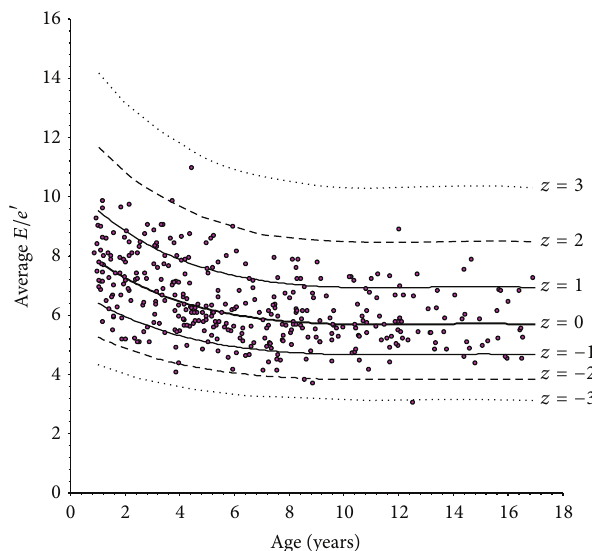
Figure 5: Scatterplot of the ratio between peak early diastolic left ventricular filling velocity ( 𝐸 ) and peak early diastolic longitudinal velocity ( 𝑒 󸀠 ) versus